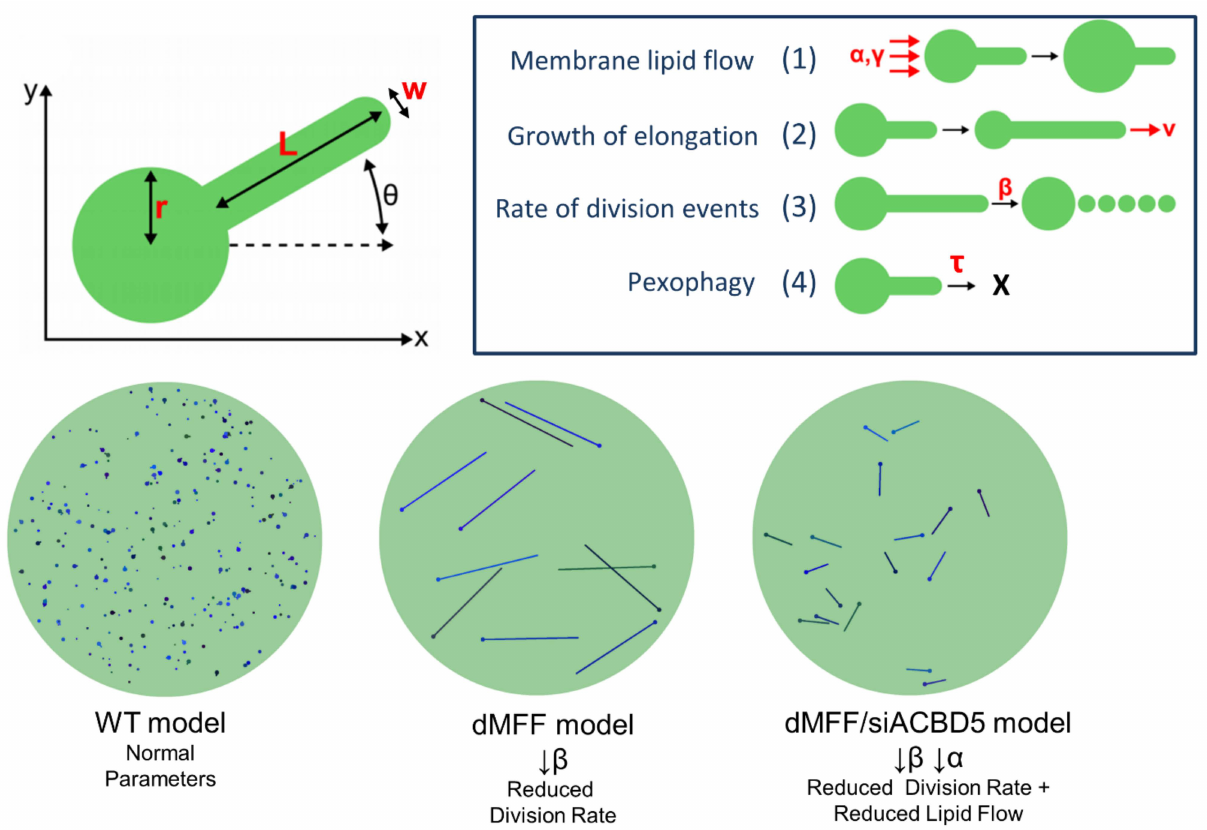
Figure 5. Mathematical model of peroxisome morphology and dynamics. Each peroxisome is represented as a spherical body of radius r and a cylindrical elongation of length L and diameter w. The model considers: (1) membrane lipid flow into the body (e.g., from the ER) (governed by rate α and lipid flow constant γ ), (2) growth of the elongation (governed by speed v), (3) peroxisome division (with rate per unit length β ), and (4) peroxisome turnover (“pexophagy”) (governed by the peroxisome mean lifetime τ ). Snapshot of the model simulation for wild type cells (normal parameters), MFF-deficient cells (dMFF) (reduced division rate) and dMFF cells with reduced lipid flow to simulate silencing of ACBD5 (adapted from